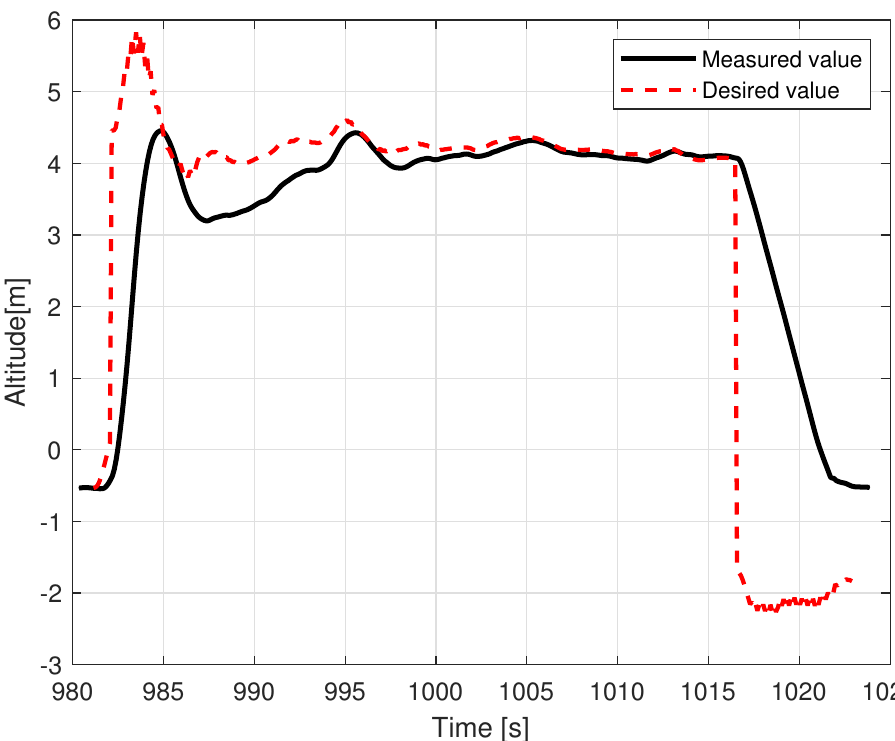
Figure 16. VTOL altitude during the in-flight